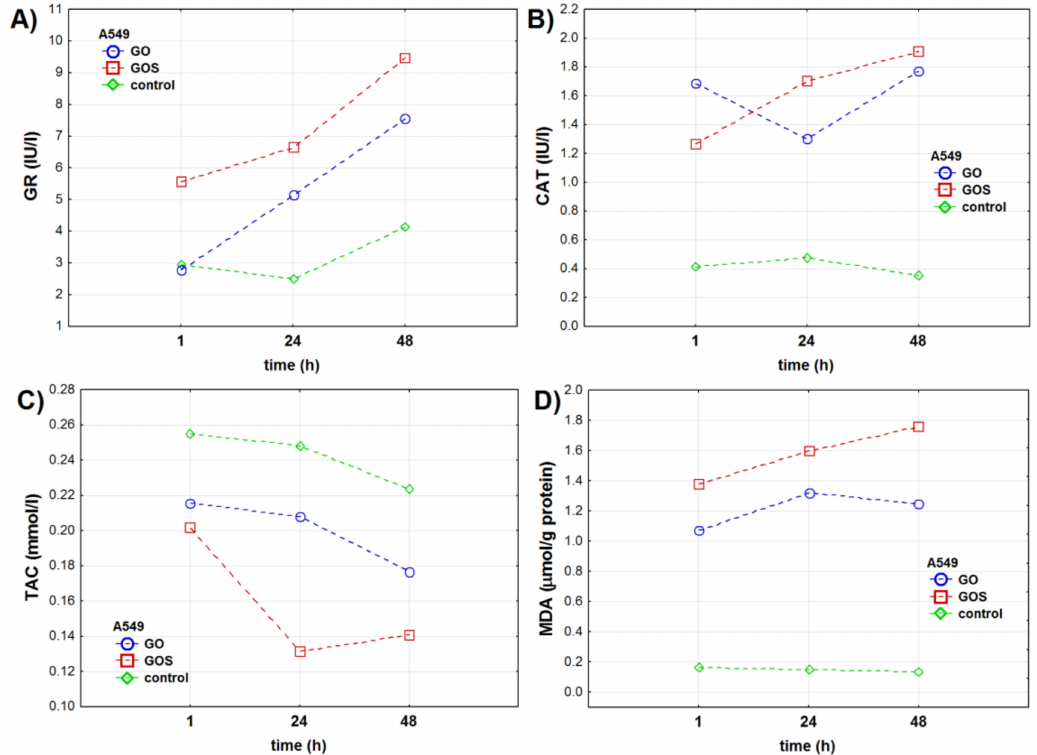
Figure 2. Oxidative stress markers in the in the A549 (adenocarcinomic human alveolar basal epithelial cells) cell line measured 1, 24, and 48 h after exposure to ultrapure (GO) or manganese ions-contaminated graphene oxide (GOS): ( A ) glu- tathione reductase (GR) activity (IU/L), ( B ) catalase (CAT) activity (IU/L), ( C ) total antioxidant capacity (TAC) (mmol/L), ( D ) malondialdehyde (MDA) concentration ( µ mol/g protein). The markers present mean value of the analyzed